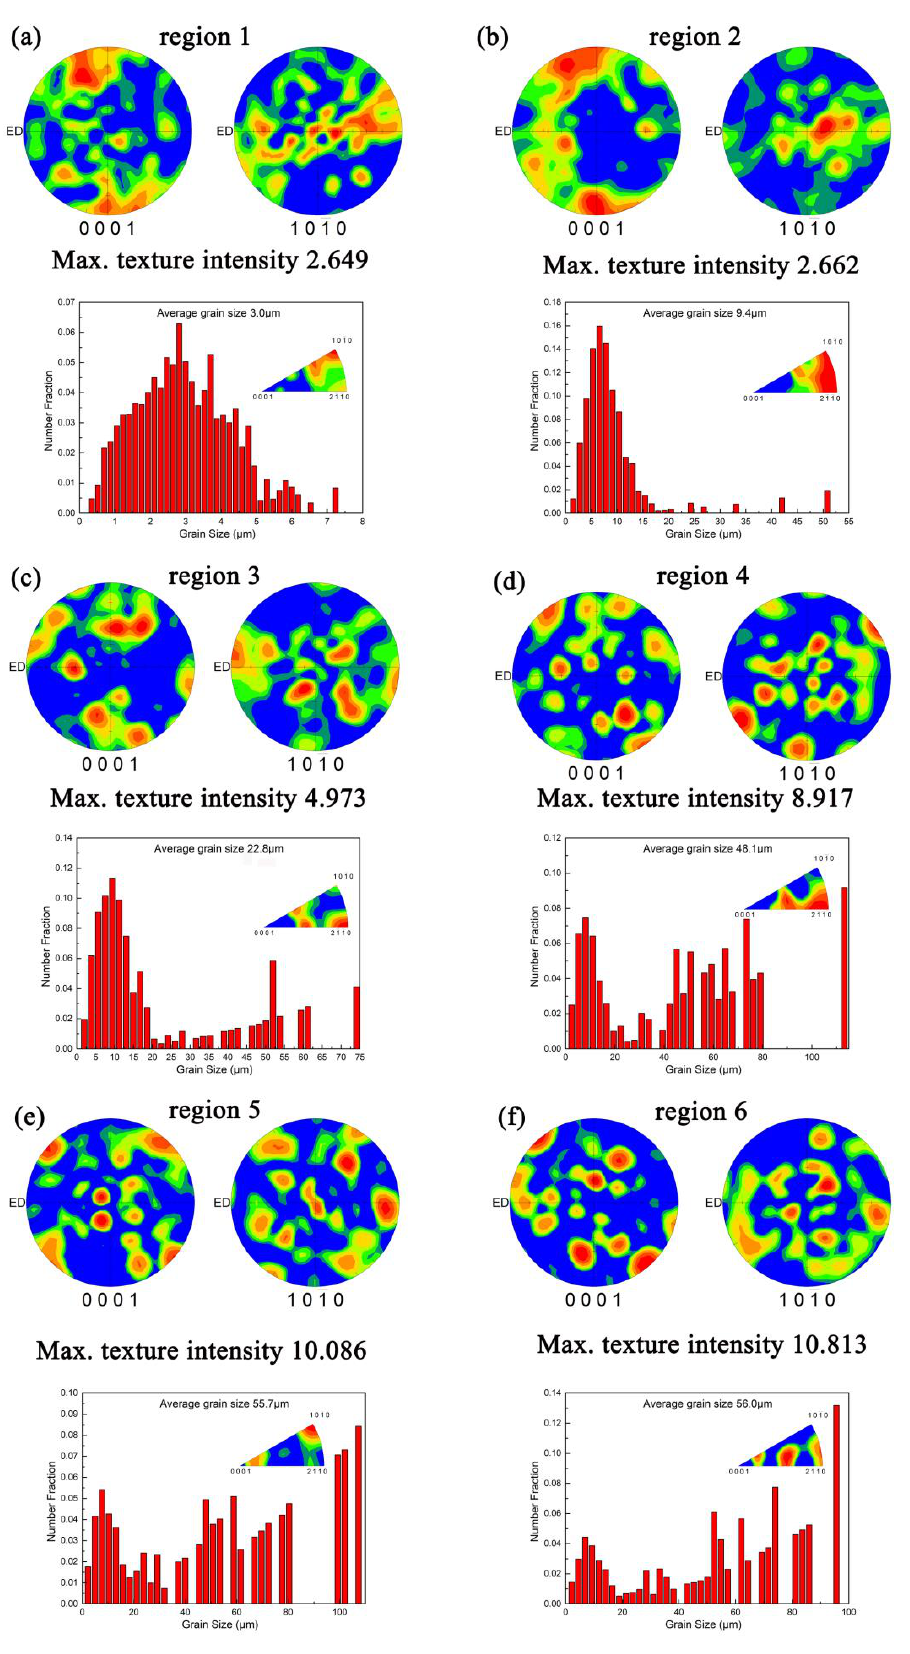
Figure 6. The corresponding grain size distribution and (0001) and (10-10) pole figures (PF) in the cross-section of the different zones along the RD.